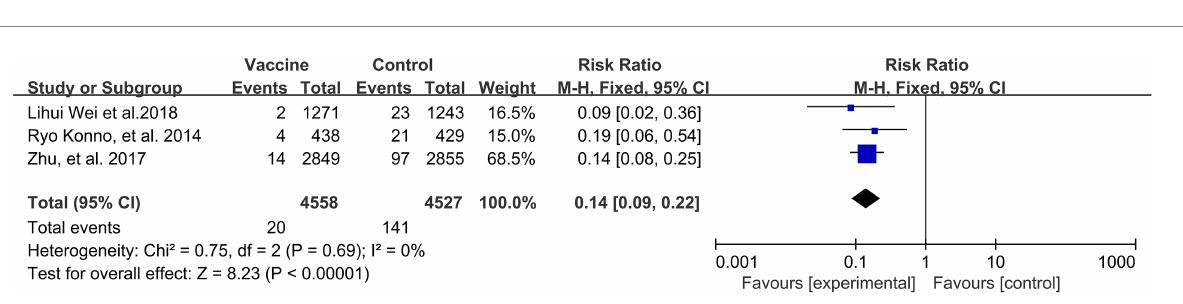
FIGURE 7 A forest plot of the meta-analysis of the incidence of HPV 16/18 associated cytological abnormality after HPV vaccination.